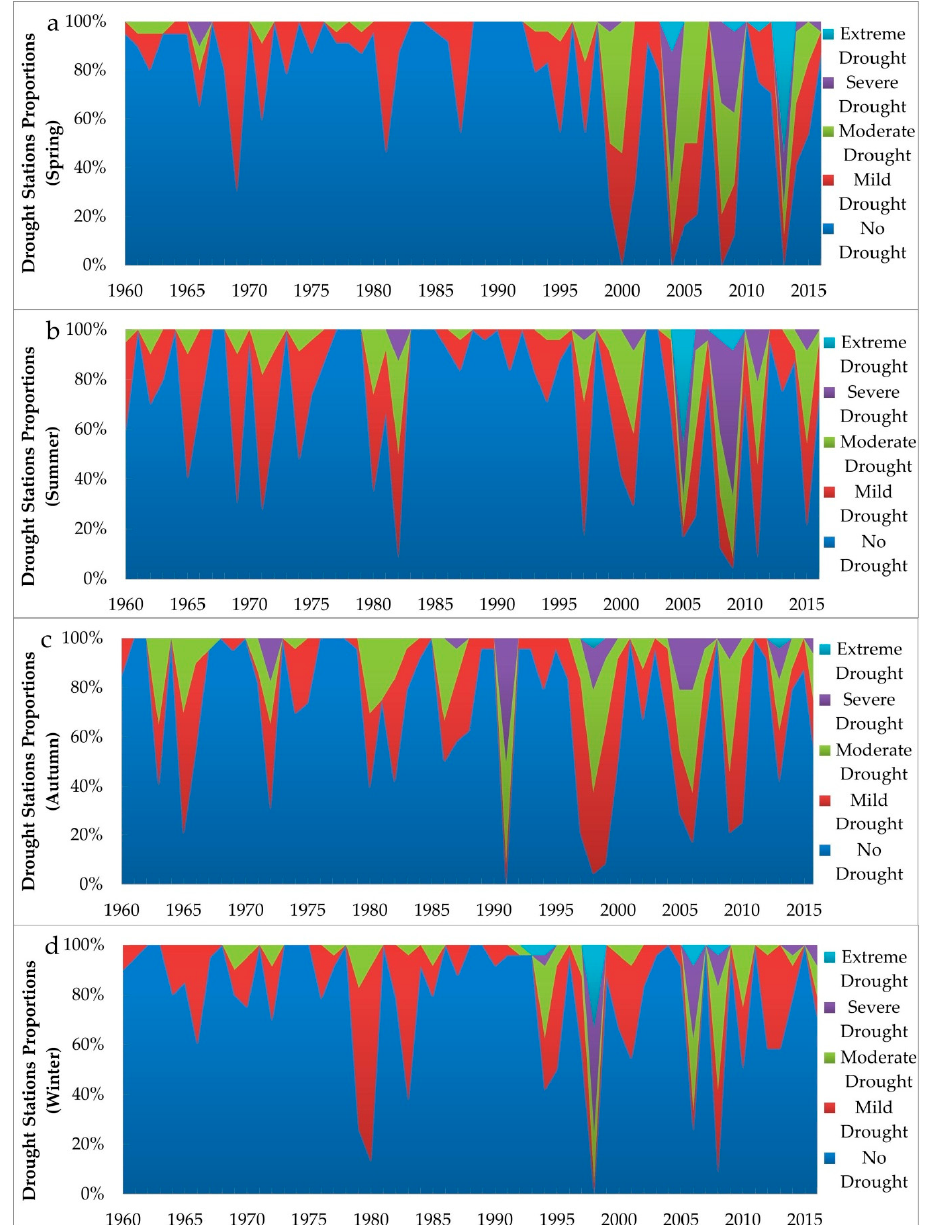
Figure 6. Interannual variation percentage accumulation of the drought stations proportions at different drought degrees in ( a ) spring, ( b ) summer, ( c ) autumn, and ( d ) winter.